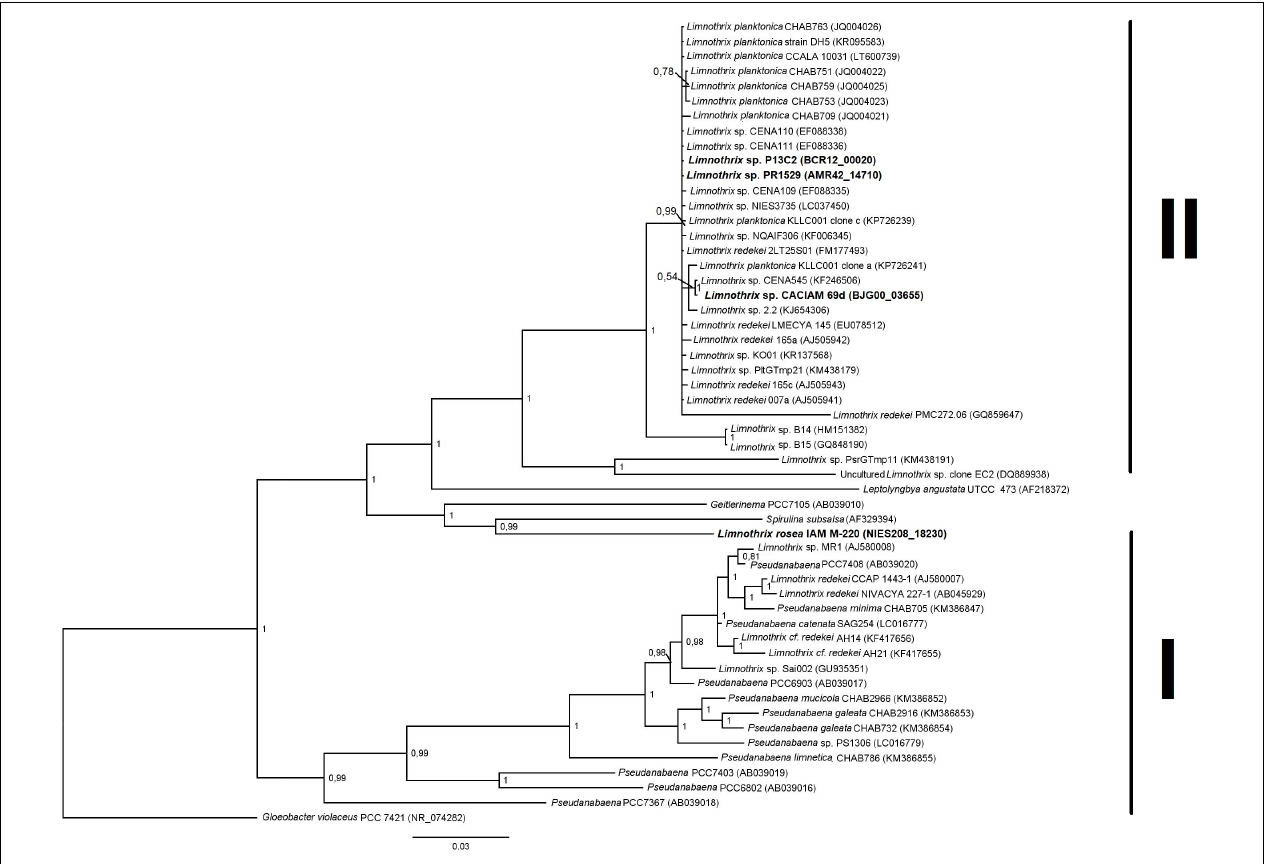
FIGURE 2 | Bayesian phylogenetic tree based on 16S rRNA sequences from Limnothrix strains and other Oscillatorian genera. Limnothrix strains with sequenced genomes are shown in bold. Gloeobacter violaceus PCC 7421 was used as outgroup. GenBank accession numbers are in parentheses.